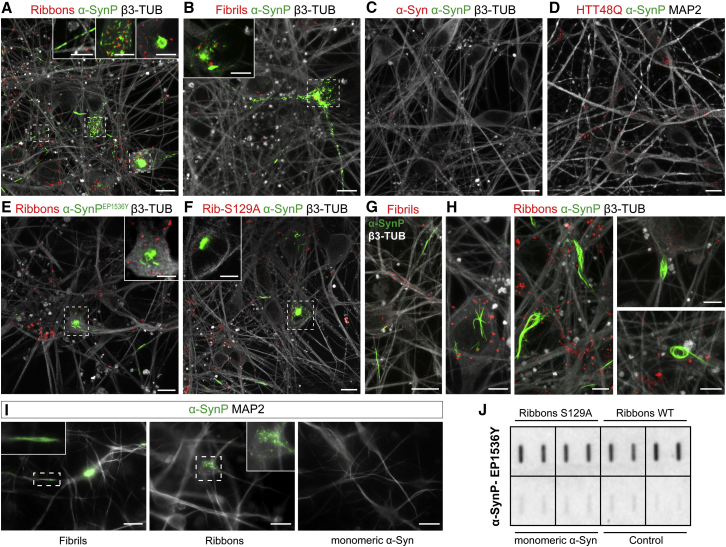
Immunofluorescence Analysis of Seeded Endogenous α-Syn Aggregation in hiPSC-Derived Cortical Neurons(A–F) Fluorescence confocal imaging of endogenous α-SynP (green) in human cortical neurons (β3-TUB or MAP2, gray) at 30 dpe to 500 nM Atto-550 (red) (A and E) α-Syn ribbons, (B) α-Syn fibrils, (C) monomeric α-Syn, (D) HTTExon1Q48, and (F) S129A ribbons using two different α-SynP antibodies (α-SynP, ab59264 in A–D and F–H, and α-SynPEP1536Y, ab51253 in E). The regions boxed with dashed lines are enlarged and represented as single plane in the insets. Scale bars: 10 μm, 5 μm in insets.(G and H) Representative images showing that α-SynP inclusions triggered by either (G) fibrils or (H) ribbons exhibit different classes of shapes (green, α-SynP; white, β3-TUB; red, exogenous assemblies); scale bar: 10 μm in (G), 5 μm in (H).(I) Resistance of endogenous α-SynP signal to paraformaldehyde/Triton X-100 fixation/extraction immunofluorescence protocol (green, α-SynP; white, MAP2); scale bar: 20 μm.(J) Filter trap assay for α-SynP (α-SynPEP1536Y antibody) in cortical neuron lysates at 30 dpe to ribbons made of wild-type or S129A α-Syn or monomeric α-Syn or in the absence of treatment. Each square represents duplicates of the sample.